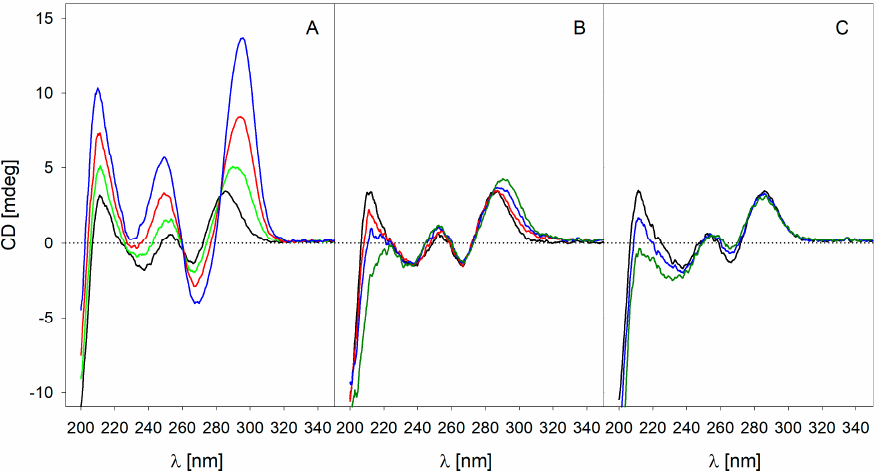
Figure 2. CD spectroscopic evaluation of the molecular interaction of BC 007 with sequence sections of the CDR-H3 regions of anti-SARS-CoV-2 antibodies. The BC 007 (21.5 µM) folding success in presence of no peptides (control, black curves) and increasing concentrations of peptides ( A ) ARARGSSGWYRIGTRWGNWFDP (source: CV07-270, PDB ID 6XKP), ( B ) ARDGVIPPRFDY (source: CV07-209 of [21] ) and ( C ) AGSDNYGFPYNGMDV (source: CV-250, PDB ID: 6XKQ) up to a molar excess as indicated by the color of the curve was measured. Green, red, and blue curves show the BC 007 spectra with additional presence of 6.25, 12.6, and 25.0 µM peptide, respectively.